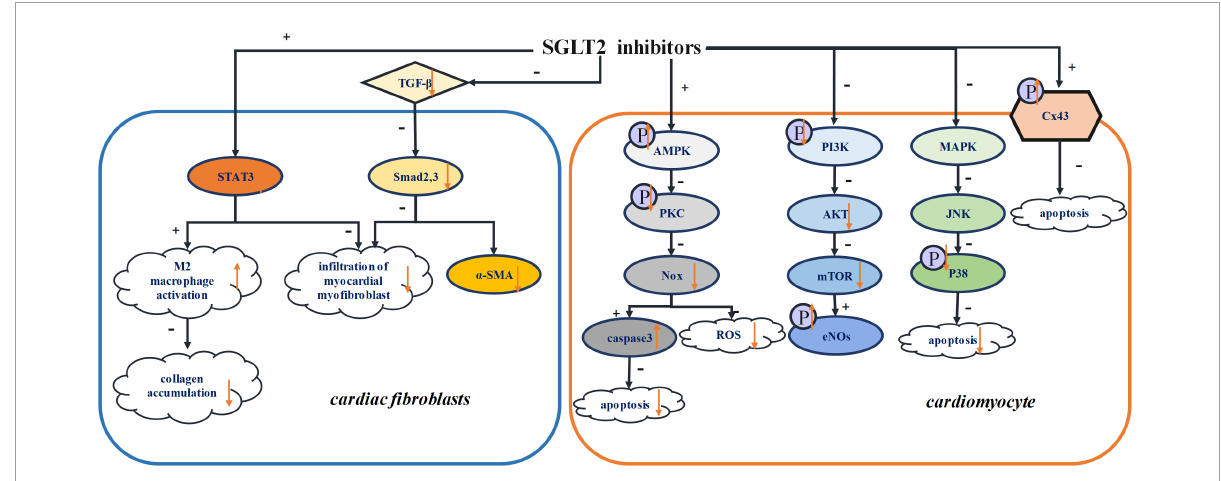
FIGURE2 Structural remodeling. STAT3, signal transducer and activator of transcription 3; TGF- β , transforming growth factor- β ; Smad2,3, mothers against decapentaplegic homolog 2,3; α -SMA, α -smooth muscle actin; AMPK, adenosine monophosphate kinase; PKC, protein kinase C; Nox, NADPH oxidase; PI3K, phosphatidylinositol-4,5-bisphosphate 3-kinase; Akt, serine/threonine-protein kinase; mTOR, mammalian target of rapamycin; eNOs, endothelial nitric oxide synthase; MAPK, Mitogen-activated protein kinase; JNK, Jun N-terminal kinase; Cx43, connexin